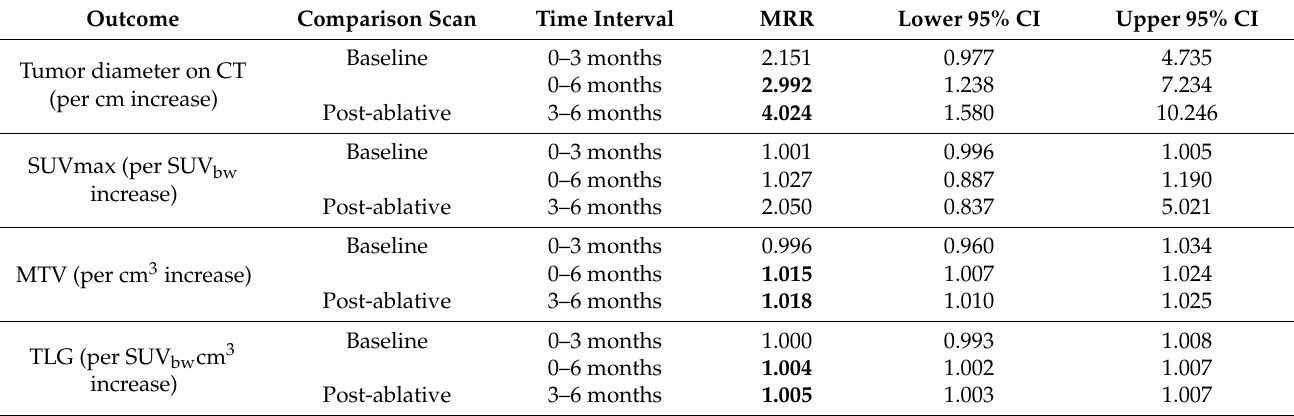
Table 4. Univariate regression analysis of exploratory continuous variables at the lesion